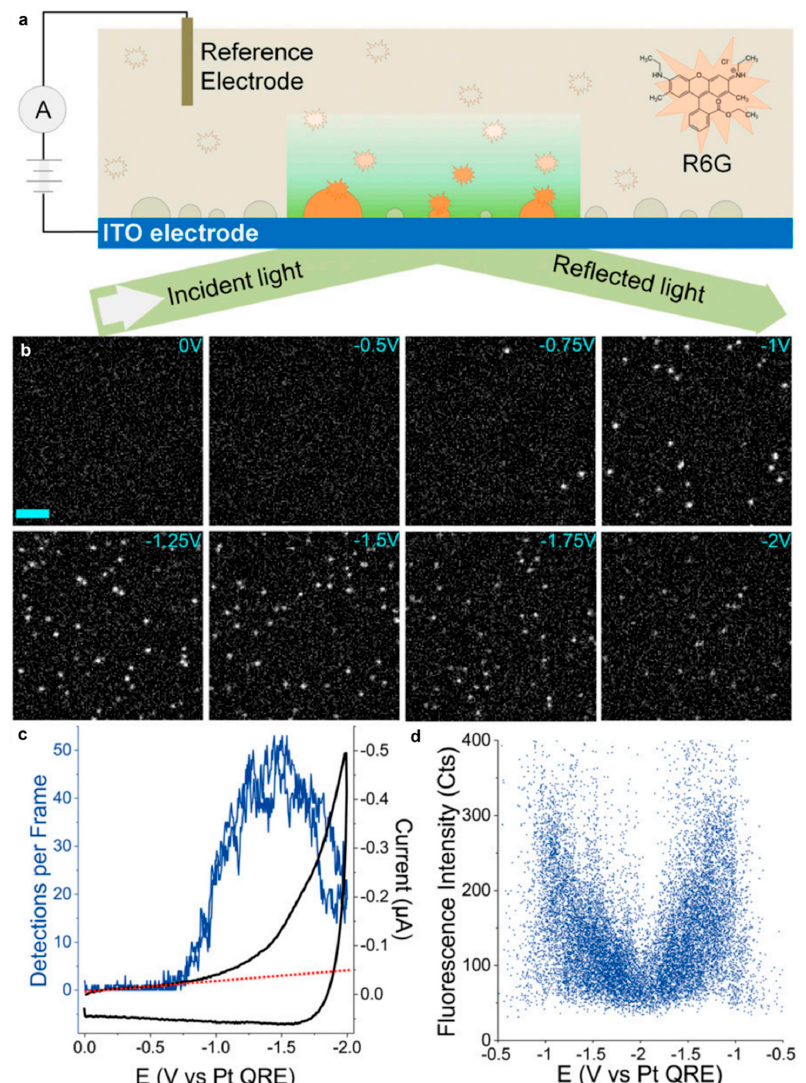
Figure 6. ( a ) A scheme of the experimental setup used for imaging H2 nanobubbles in electrocatalytic water splitting. H 2 nanobubbles generated on an ITO surface are labeled by single R6G molecules and imaged by TIRF microscopy. ( b ) A series of TIRF images of a 22.8 × 22.8 μ m 2 area on an ITO electrode taken from a potential scan from 0 V to − 2.0 V at 100 mV/s vs. Pt QRE in water containing 1 M Na 2 SO 4 and 10 nM R6G. Fluorescence images were recorded at 19.81 frames per second with a 50-ms exposure time. (Scale bar, 5 μ m.) ( c ) A comparison between the rate of nanobubble detection (detections per frame) (blue) and the current-voltage response recorded on the same electrode (black). The red dashed line indicates the baseline of the faradaic current. ( d ) A scatter plot showing the fluorescence intensity (counts) of individual H 2 nanobubbles in the potential range of interest from − 0.5 V to − 2.0 V from the same recording. The photon counts of each fluorescent burst on one frame were converted from the total integrated fluorescence signal under the fitted 2D Gaussian function using Thunder